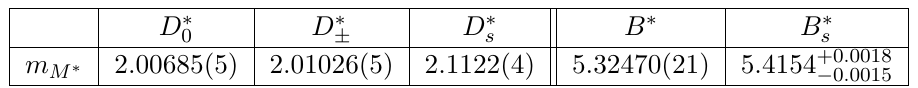
Table 18. Masses of the excited mesons in GeV, relevant for spectroscopic determinations, taken from PDG values [21]. Uncertainties in the final digit(s) are neglected in this study, but are given in brackets, except for B ∗ which currently has asymmetric uncertainty. s